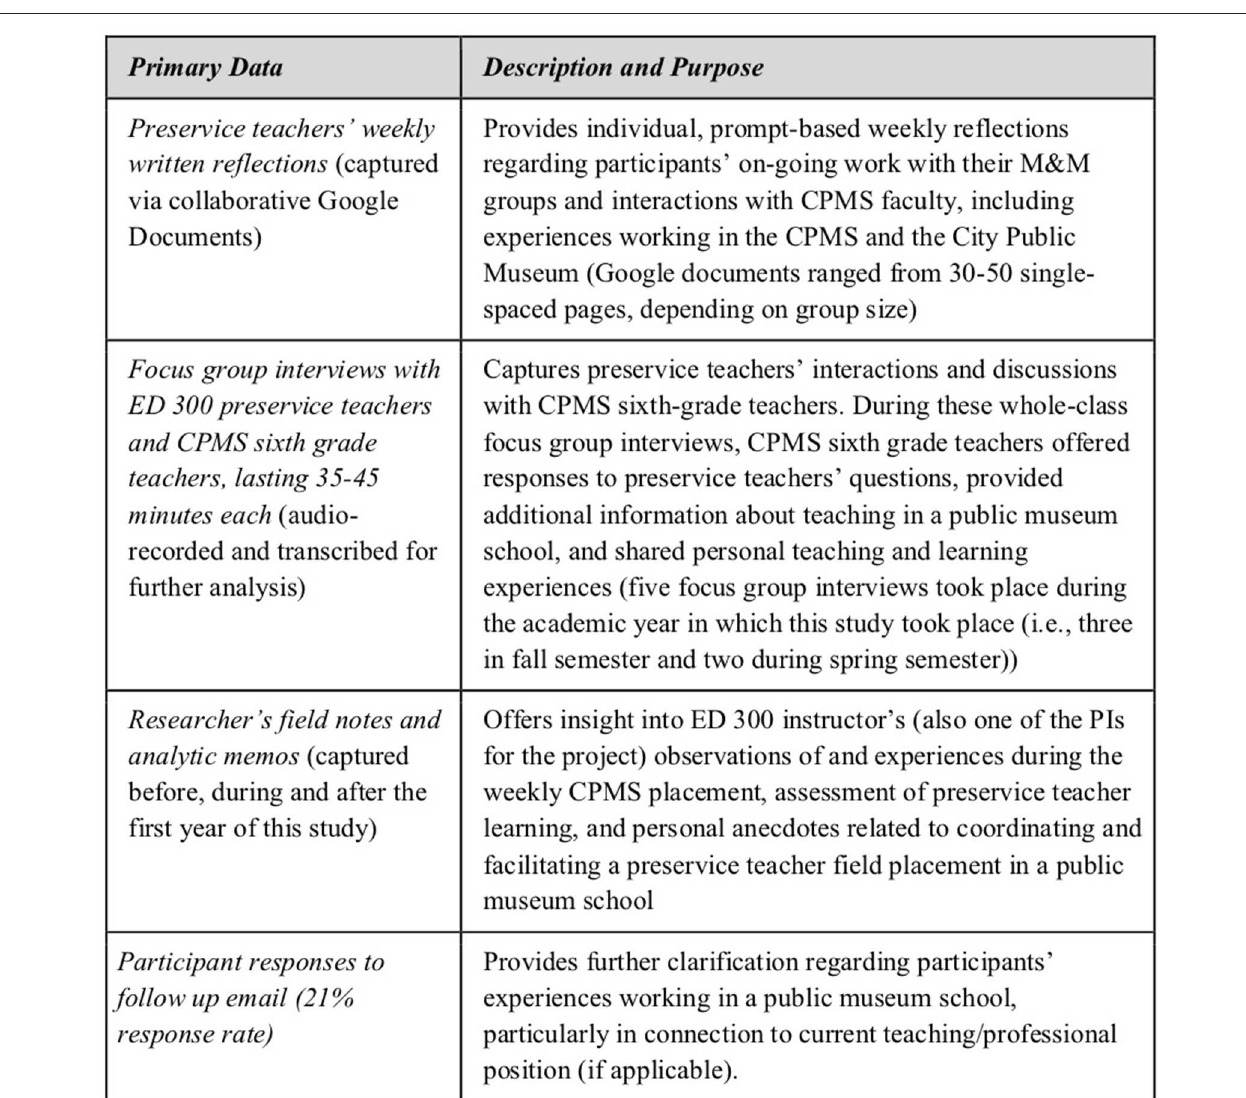
FIGURE 3 | Primary data